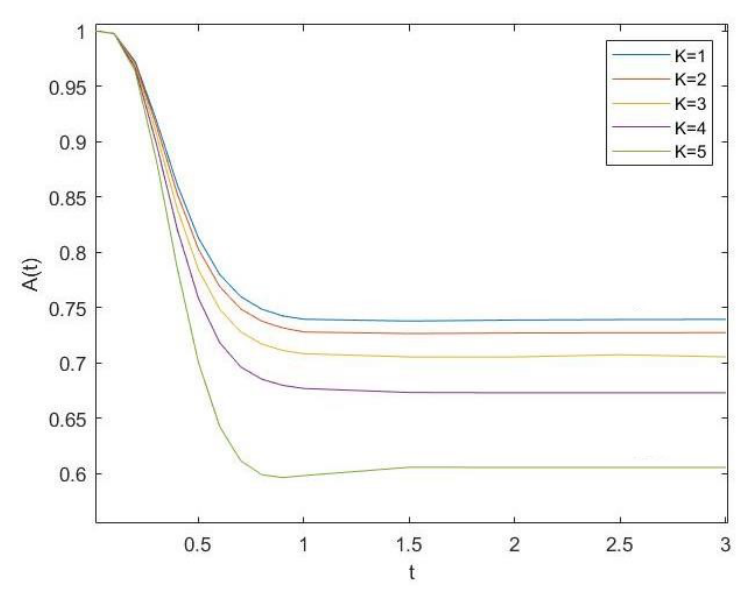
Figure 2. Availability function for systems K = 1,2,3,4,5.